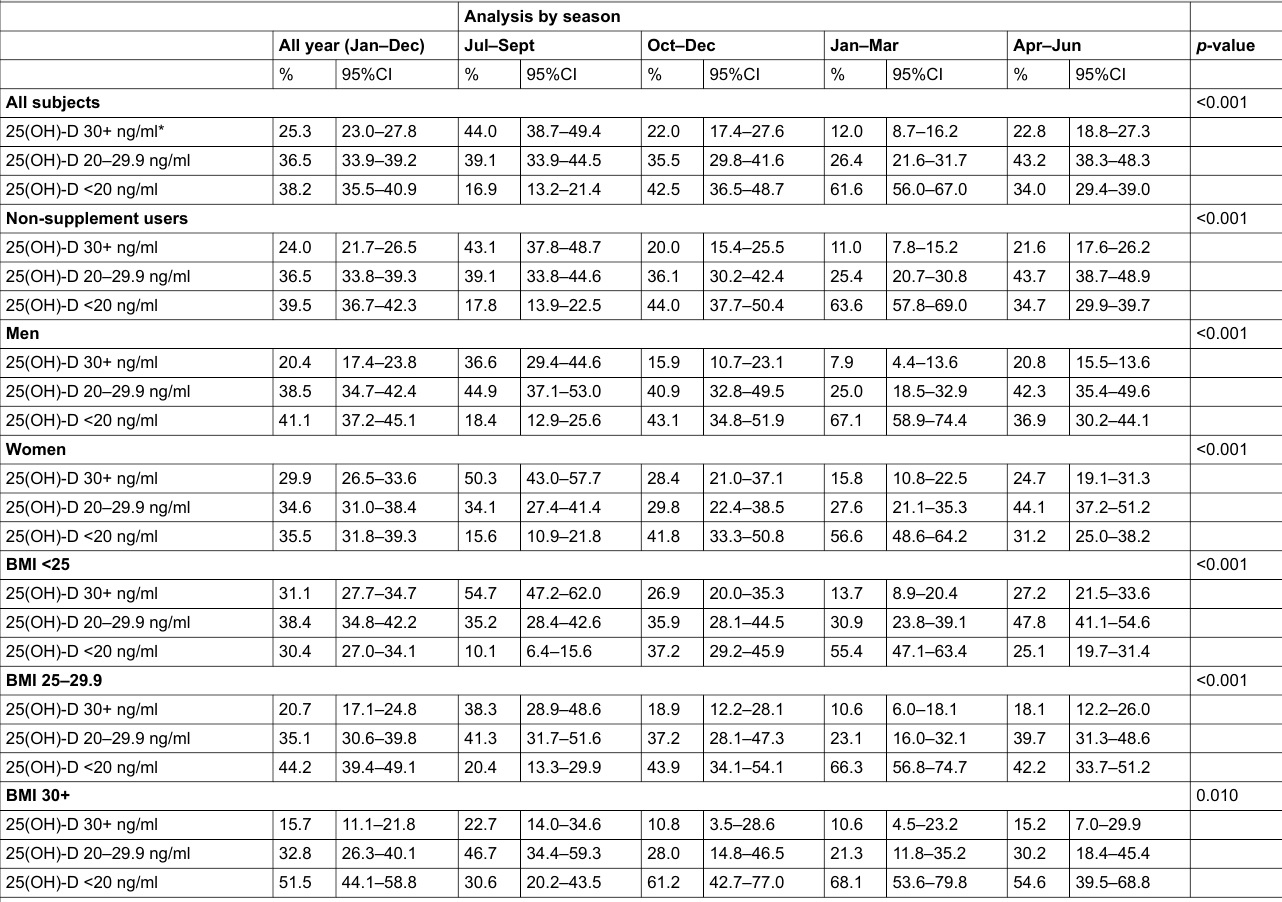
Table 2: Prevalence of vitamin D sufficiency (30+ ng/ml), insufficiency (20–29.9 ng/ml), and deficiency (<20 ng/ml)*, by characteristics and